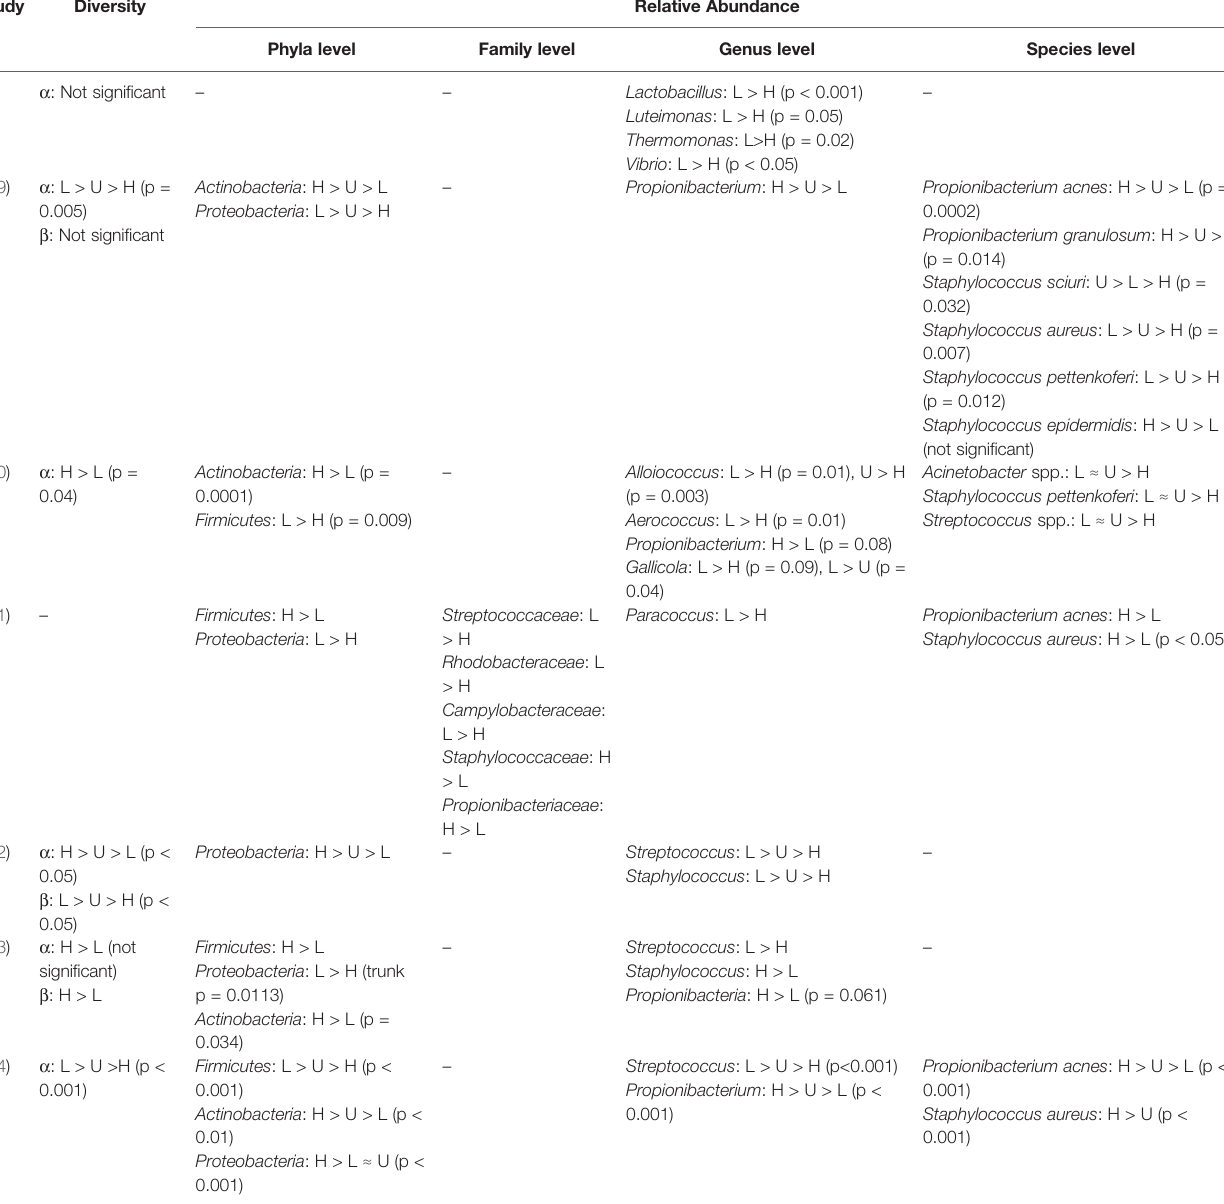
TABLE 2 | Summary of bacterial diversity and taxonomic characteristics on psoriatic skin in clinical